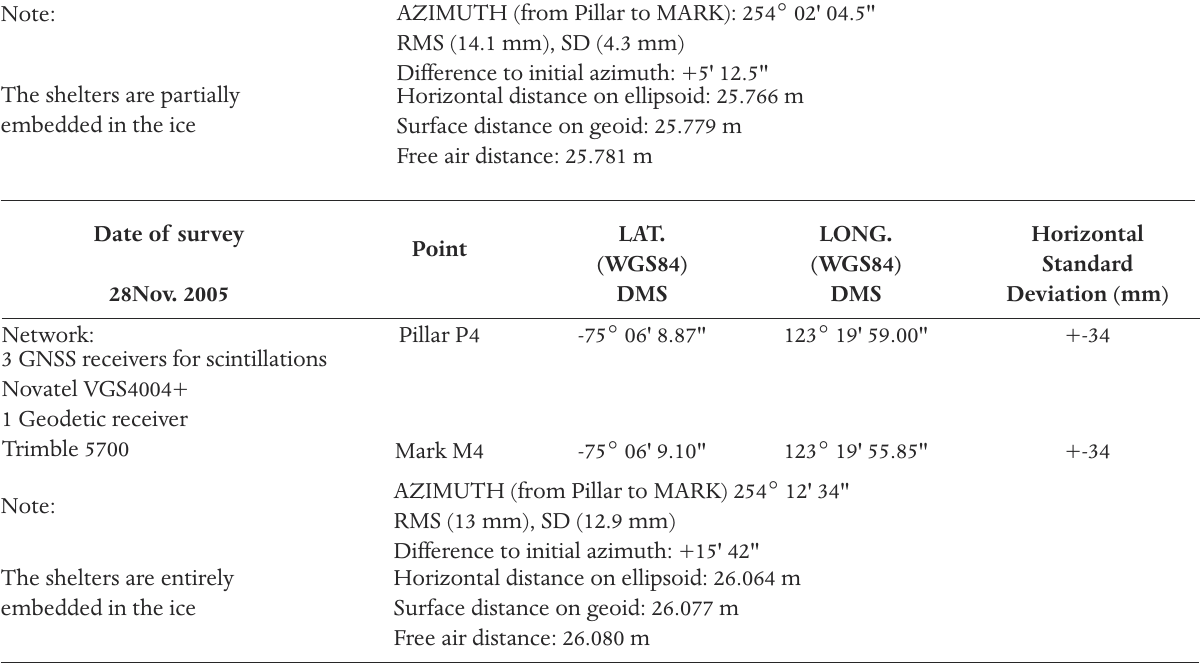
Table 2. Summary results for positioning surveys performed in 2005, 2007, 2009 and 2013 (from top to bottom) aimed to determine precise angular direction between the pillar and the azimuth mark at Concordia geomagnetic